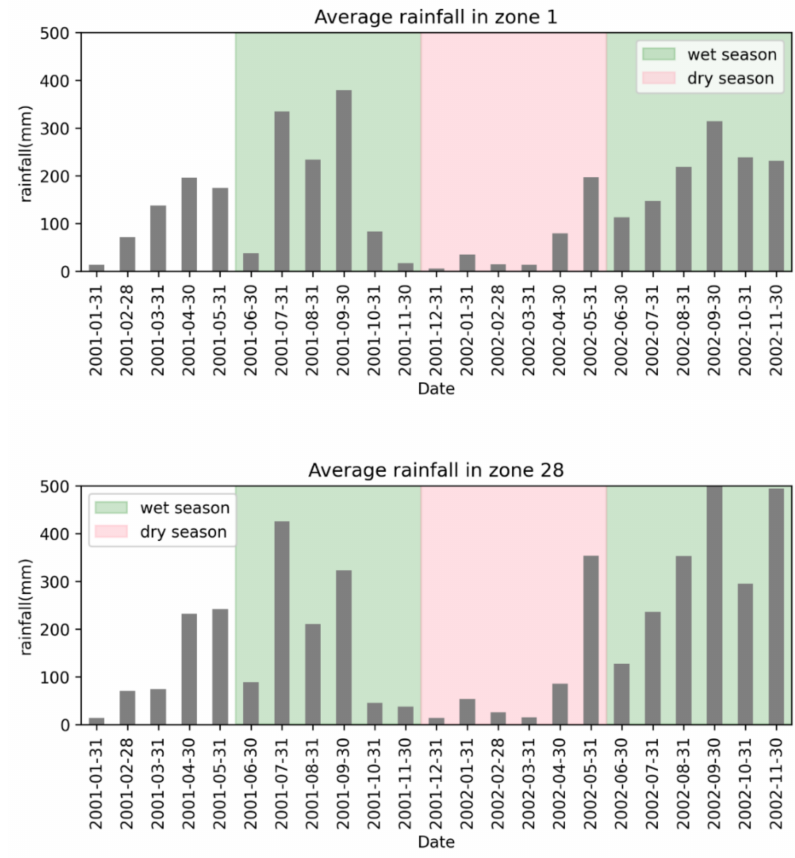
Figure 5. Average rainfall distribution in Zone 1 and Zone 28.